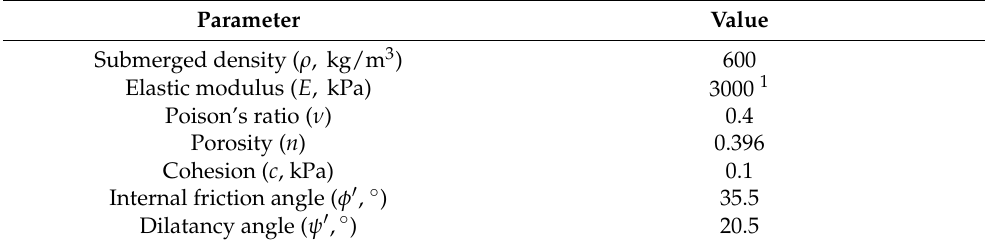
Table 4. Mechanical and strength parameters of soil for numerical model for physical model test. Parameter Value Submerged density ( ρ , kg/m 3